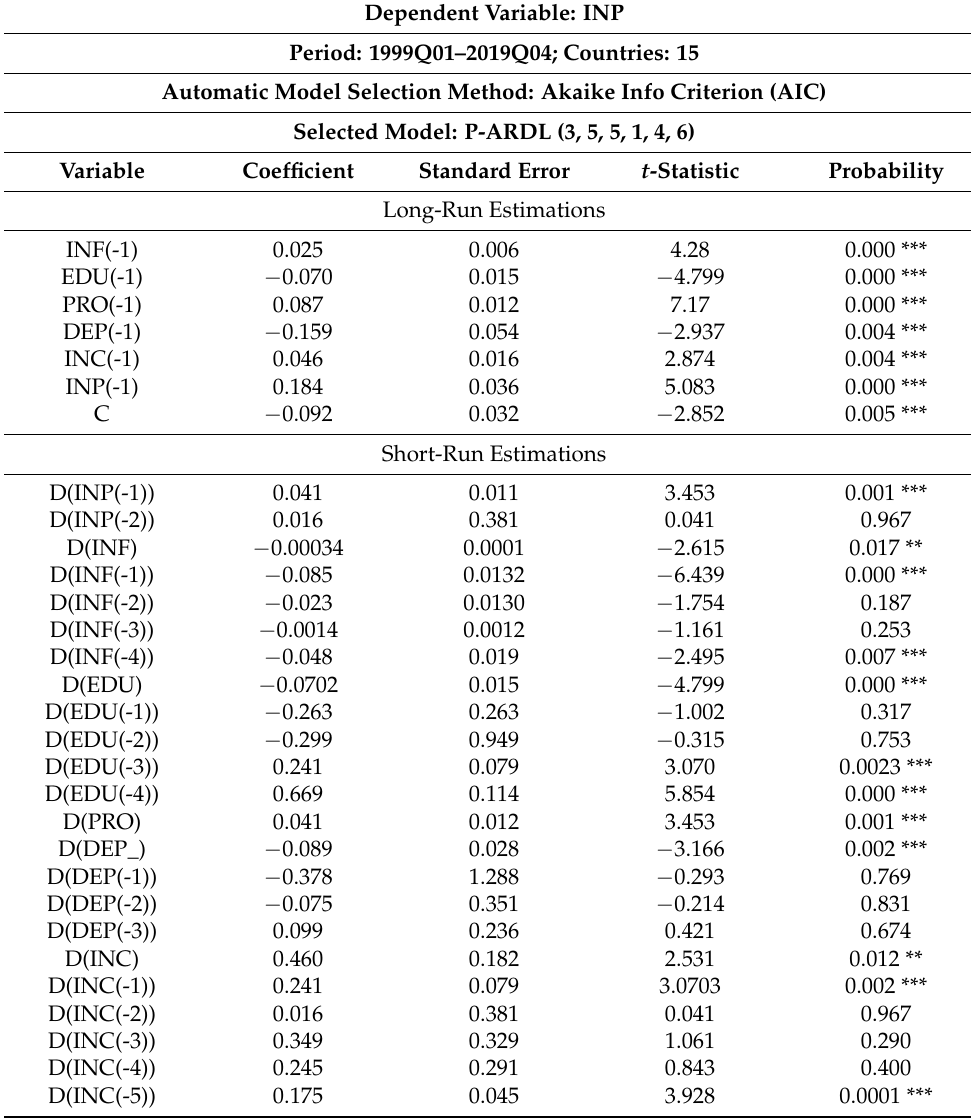
Table 6. P-ARDL estimation: INP, INF, EDU, PRO, DEP, INC. Dependent Variable: